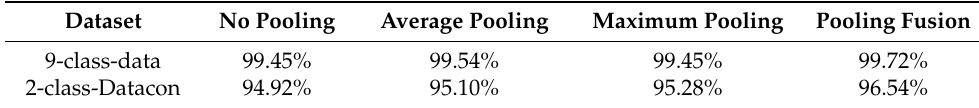
Table 7. Accuracy for different pooling